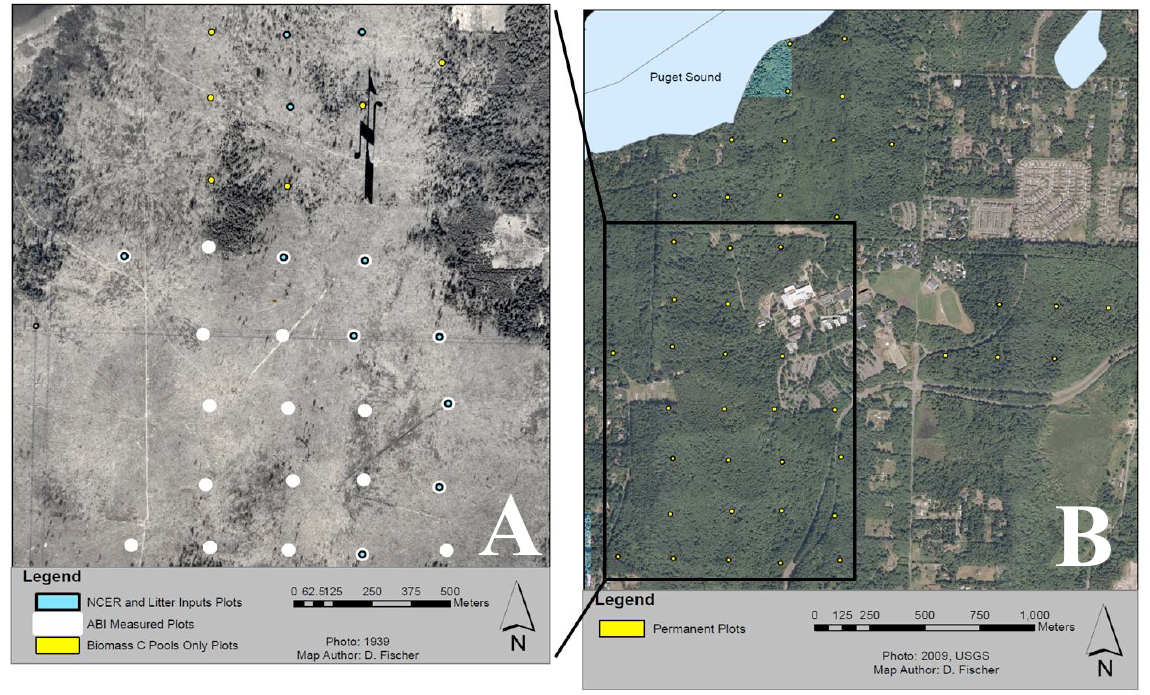
Figure 1. Map of study area depicting circular 10 m radius permanent plots along a 250 m grid with a random starting point: (A) Historical (1939) photo of the study area showing part of a clear-cut which took place from 1937-39. Blue dots depict the subset of 11 plots measured for soil CO efflux and leaf litter, white dots depict the subset of 21 plots 2 measured for aboveground biomass increment (ABI), and yellow dots depict 6 of the 44 plots measured for aboveground biomass pools only. (B) Locations of all 44 permanent plots measured for aboveground biomass pools only. For reference The Evergreen State College is located at the center of the